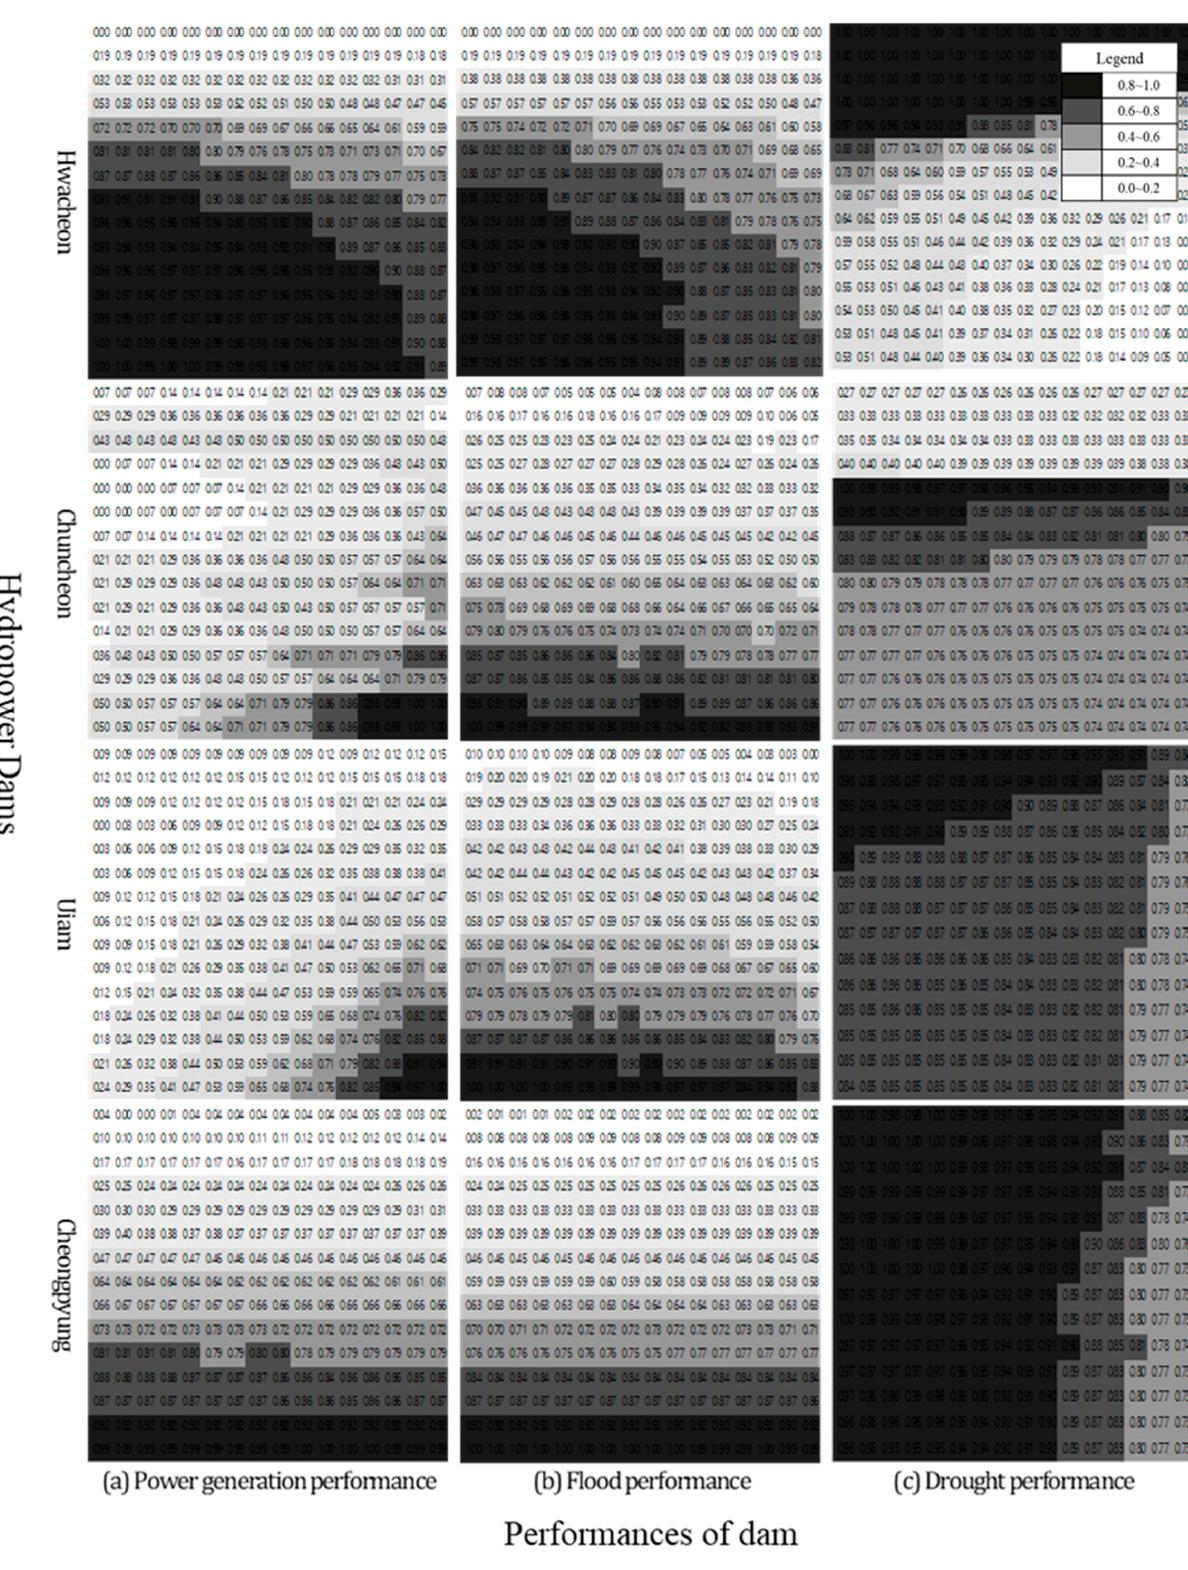
Figure 9. Performance matrix for each hydropower reservoir. ( a ) is the matrix calculated by Equation (2) as an evaluation of the power generation performance. ( b ) is the matrix calculated by Equation (3) as and evaluates the flood control ability. ( c ) is the matrix calculated by Equation (4) and evaluates the drought control ability.